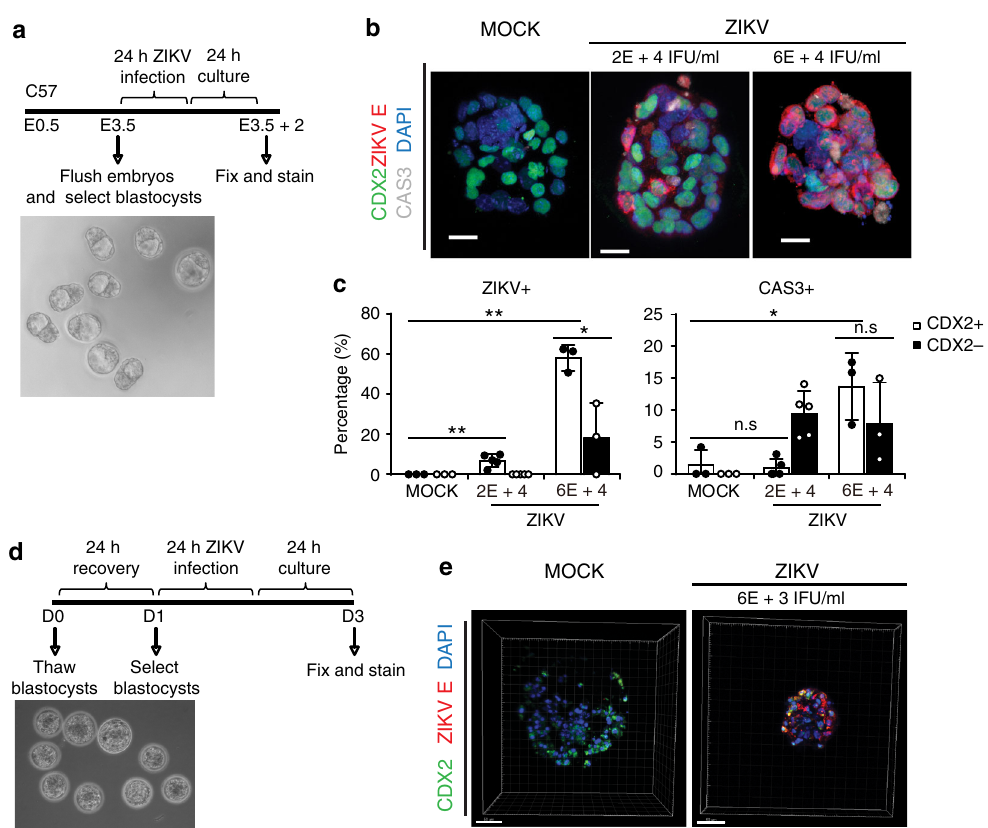
Fig. 1 Human and mouse trophectoderm can be infected with ZIKV. a Scheme of ZIKV infection on mouse blastocysts in vitro, including phase contrast image of blastocyst-staged embryos prior to infection. b ZIKV infection (ZIKV E) and cell apoptosis (Cleaved Caspase3/CAS3) in mouse trophectoderm (CDX2) was indicated by immunostaining of mouse blastocysts at 24 h post infection with MR766 strain ZIKV at 2 × 10 4 IFU ml − 1 and 6 × 10 4 IFU ml − 1 . n = 3 MOCK, n = 5 ZIKV 2 × 10 4 IFU ml − 1 , n = 3 ZIKV 6 × 10 4 IFU ml − 1 . Scale bar = 20 µ m. c Quanti fi cation of ZIKV E + cells and CAS3 + cells among CDX2 + trophectoderm in embryos immunostained in b . n = 3 MOCK, n = 5 ZIKV 2 × 10 4 IFU ml − 1 , n = 3 ZIKV 6 × 10 4 IFU ml − 1 . d Scheme of ZIKV infection on human pre-implantation embryos in vitro, including phase contrast image of embryos prior to infection. e ZIKV (ZIKV E) infection in human trophectoderm (CDX2) was indicated by immunostaining of human embryos at 24 h post infection with MR766 strain ZIKV. n = 3 MOCK, n = 2 ZIKV. Scale bar = 50 µ m. Data are presented as mean ± standard deviation. P values were calculated by multiple unpaired two-tailed Student ’ s t- test. * P < 0.05, ** P < 0.01, n.s. – not signi fi cant. Source data for 1c are provided as a Source Data fi